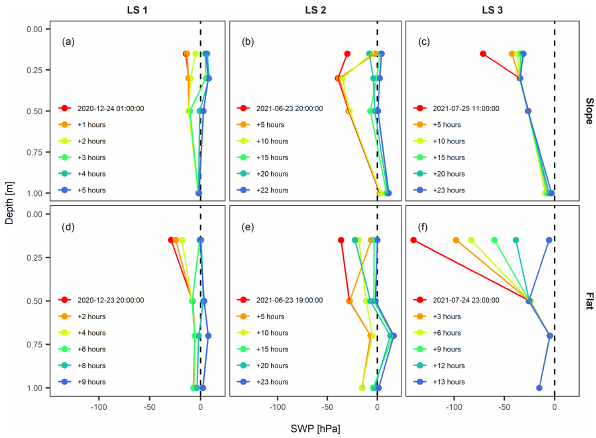
Figure 11. Depth profiles of soil water potential at the sloped (a– c) and flat site (d–f) during three landslide-triggering infiltration events (LS1, LS2, LS3). The first time step corresponds to the on- set of the respective infiltration event. LS1 and LS2 show relatively high antecedent SWP values throughout the profiles and infiltration to large depths, whereas the surface layers at LS3 were relatively dry and infiltration concentrated to the surface